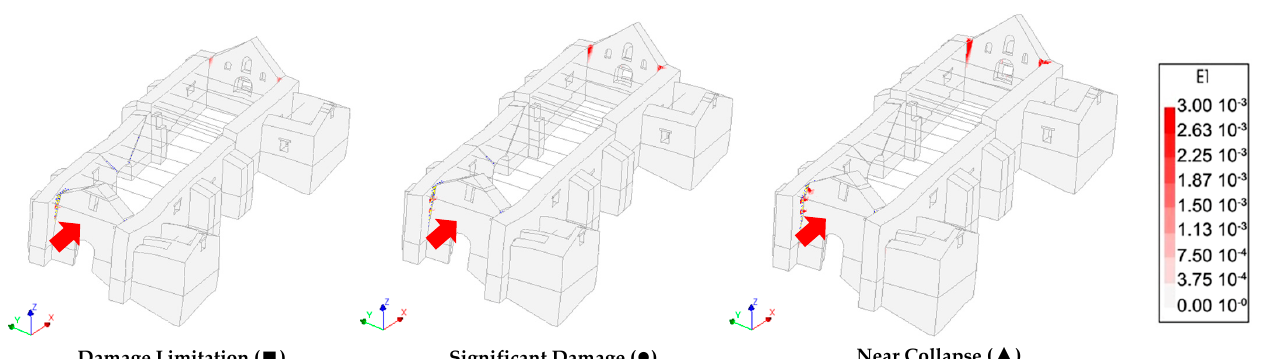
Figure 27. Damage Limitation (solid black line), Significant Damage (dotted black line) and Near Collapse (dash-dot black line) elastic demand spectra and bilinearized SDOF capacity diagrams indicating the target displacements ( ∎ , ● , ▲ ) in the +XX direction. The distribution of maximum principal plastic strains corresponding to the attainment of the target displacement at each performance level is shown in the contour diagrams.